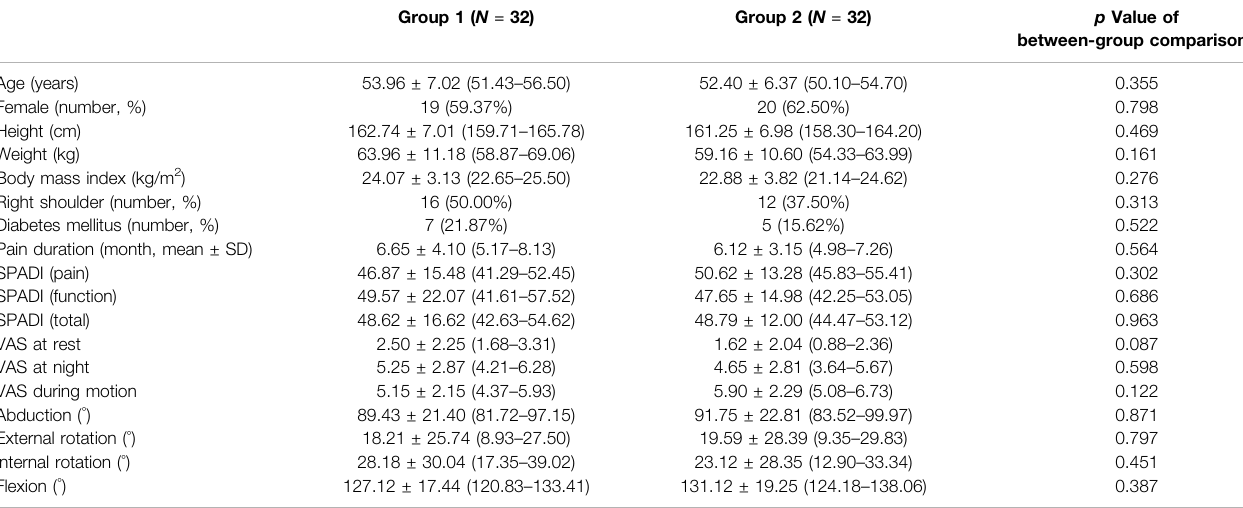
TABLE 1 | Baseline characteristics of the patients.